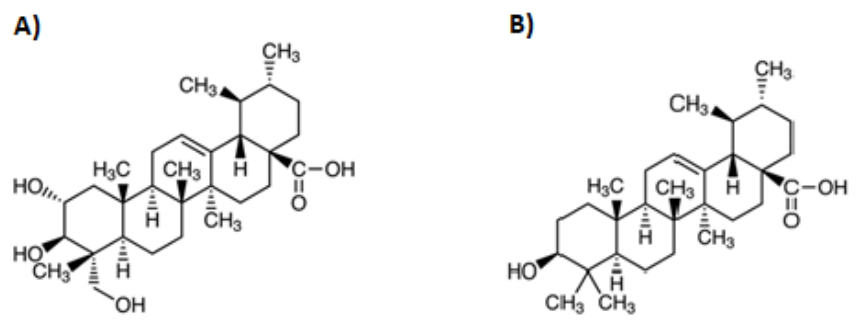
Figure 1. Chemical formulas of asiatic ( A ) and ursolic ( B ) acids.